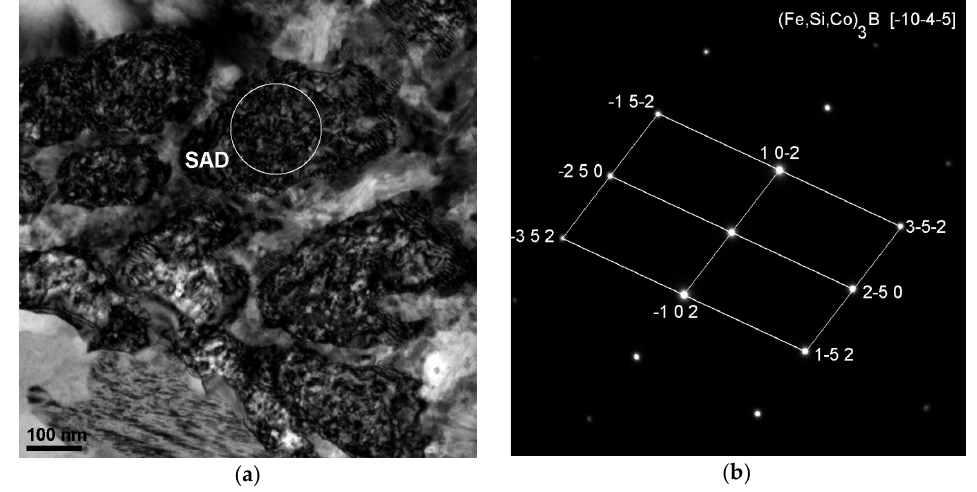
Figure 8. TEM image of the Fe 36.00 Co 36.00 B 19.00 Si 5 Nb 4 alloy in rod form with the diameter of 2.5 mm, ( a ) bright field; ( b ) the electron diffraction from the position marked SAD in (a); solution of diffraction: (Fe,Si,Co) 3 B phase. Materials 2017 , 10 , 625